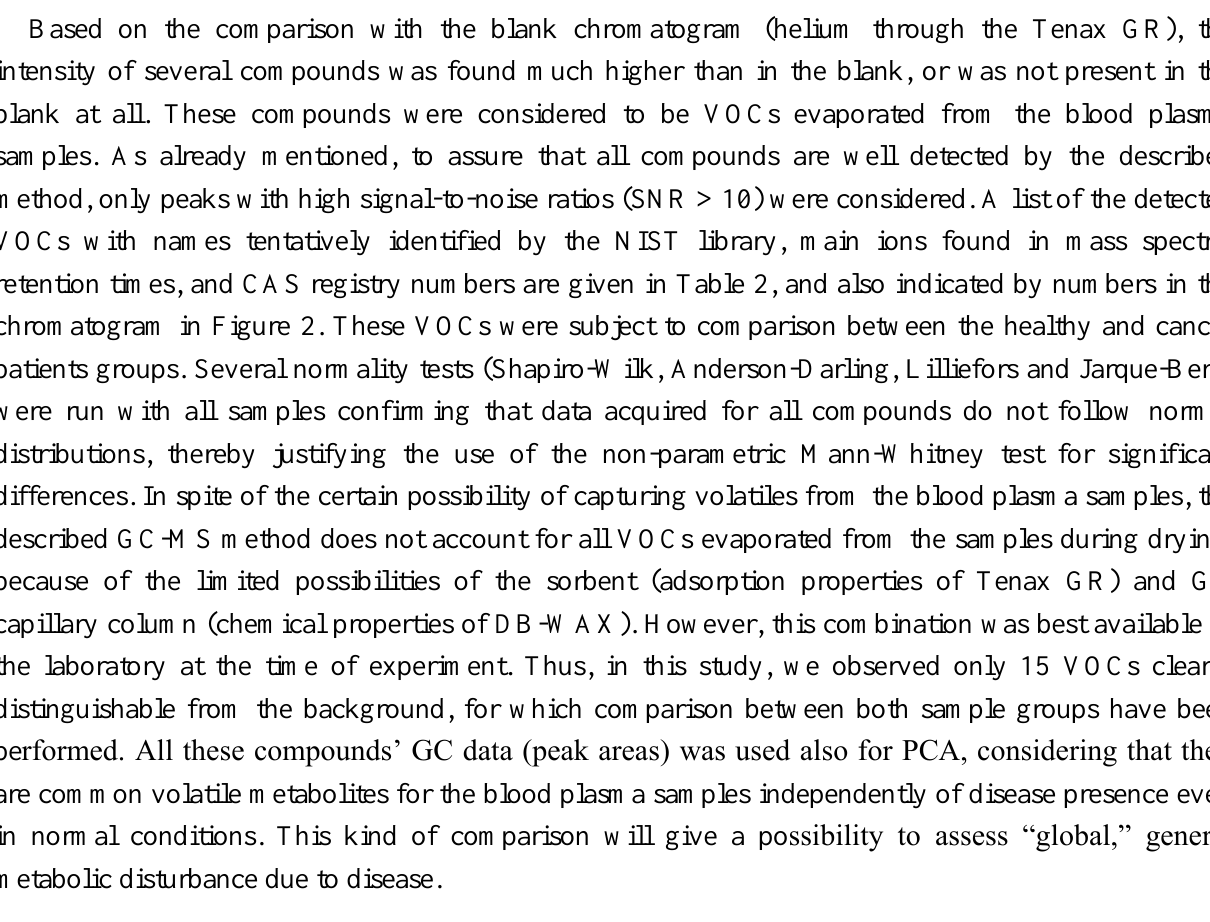
Table 2. Volatile organic compounds, metabolites detected by the thermal desorption